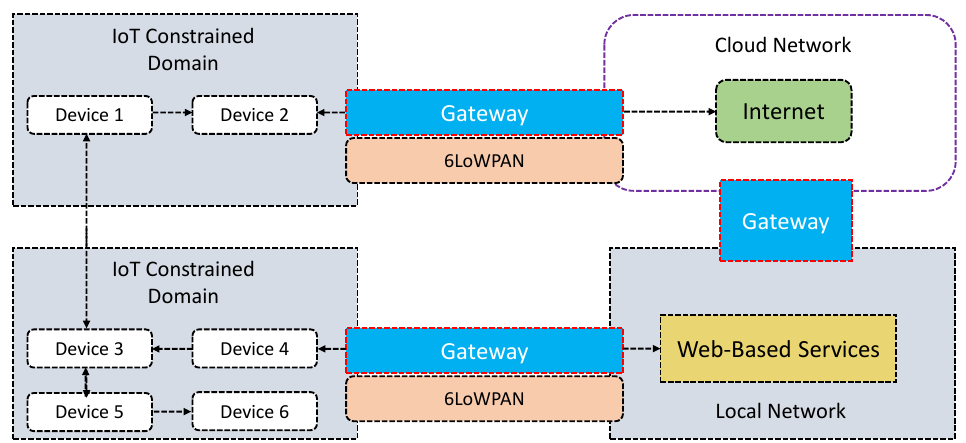
Figure 2. An outline of the proposed ProBAC model discussed in